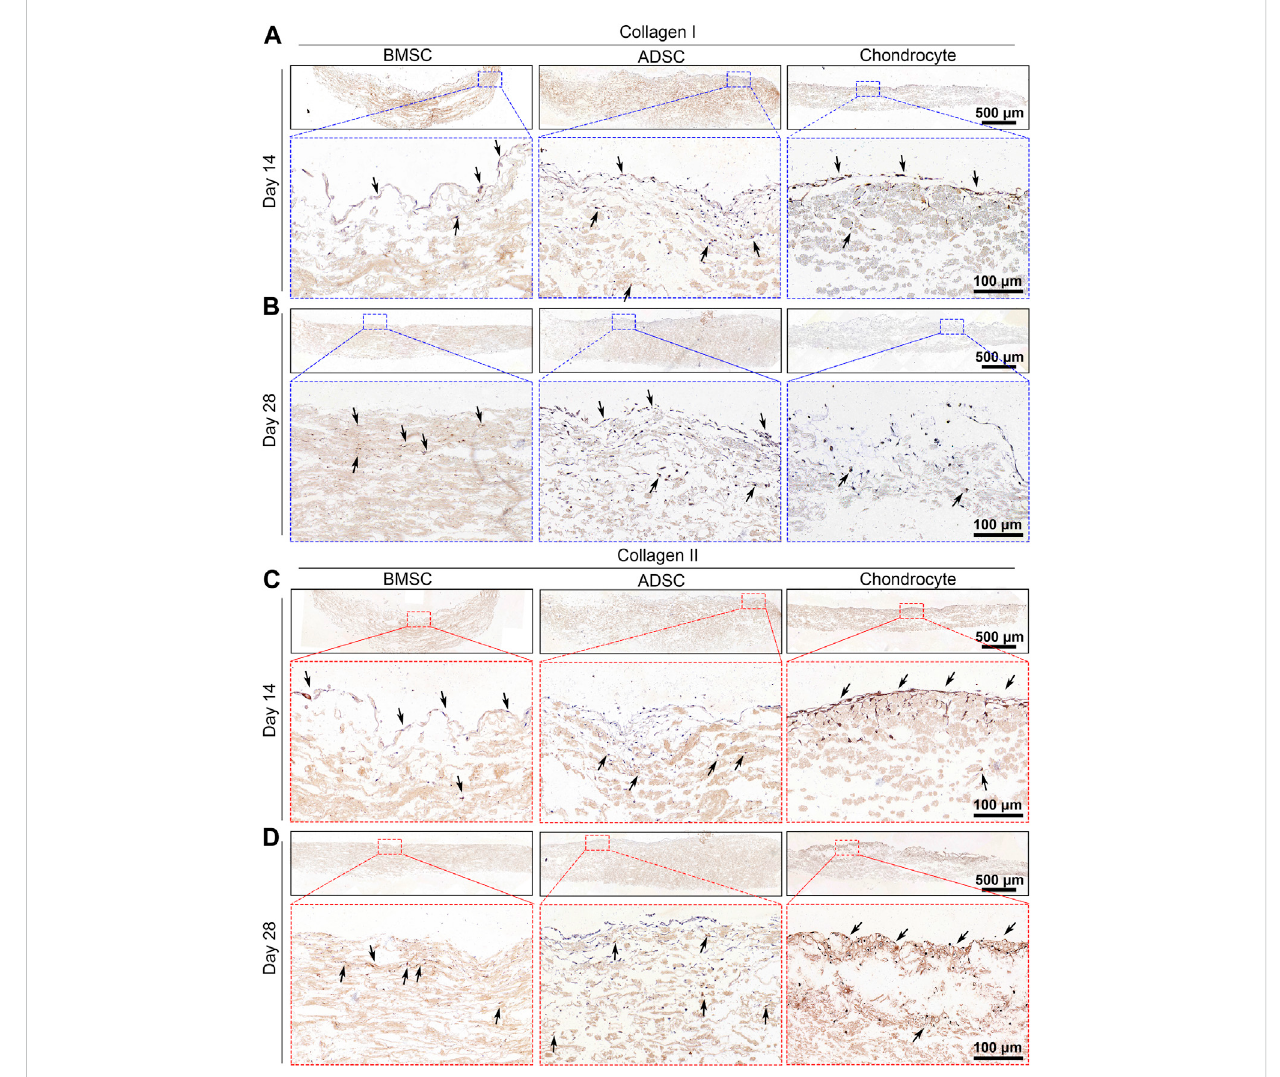
FIGURE 6 Immunohistochemical staining of cell-seeded scaffolds. BMSC and ADSC are positive in collagen I staining (A, B) but are negative in collagen II staining (C, D) . A small portion of chondrocyte shows positive collagen I staining and most chondrocytes are positive in collagen II staining.